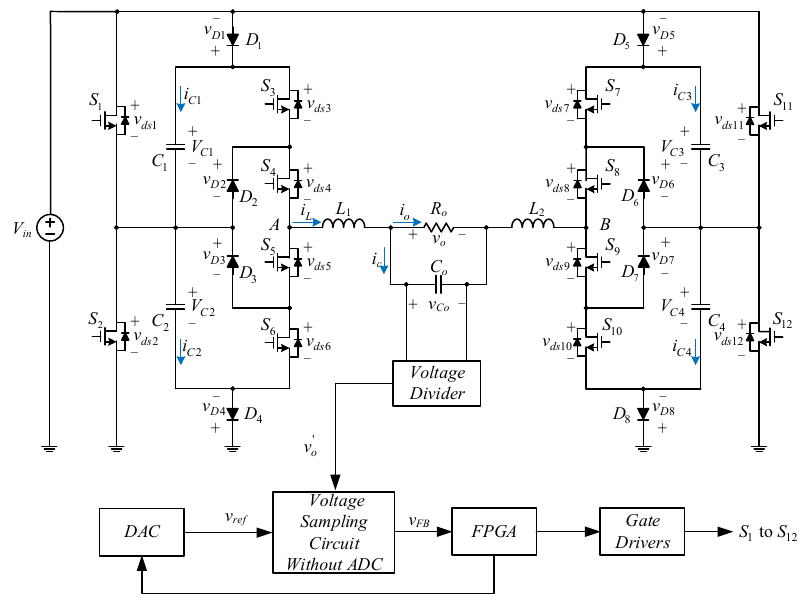
Figure 15. System block diagram of the proposed 7-level DC-AC converter.